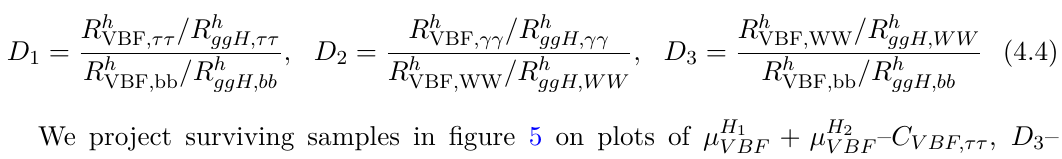
different from that measured by ATLAS and CMS. B predicted by SM even deviates bb ( WW ) beyond the experimental 1 σ error. But Samples in the scenario with two mass-degenerate Higgs bosons are much more consistent with measured data than the SM